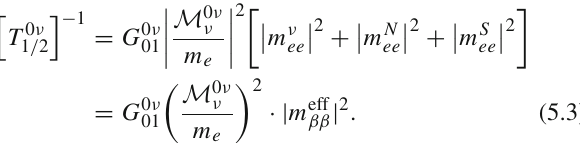
Fig. 5 The rate for μ → e conversion in Au nucleus as a function of the lightest neutrino mass, m 1 ( m 3 ) for NH (IH) due to light-heavy mixing